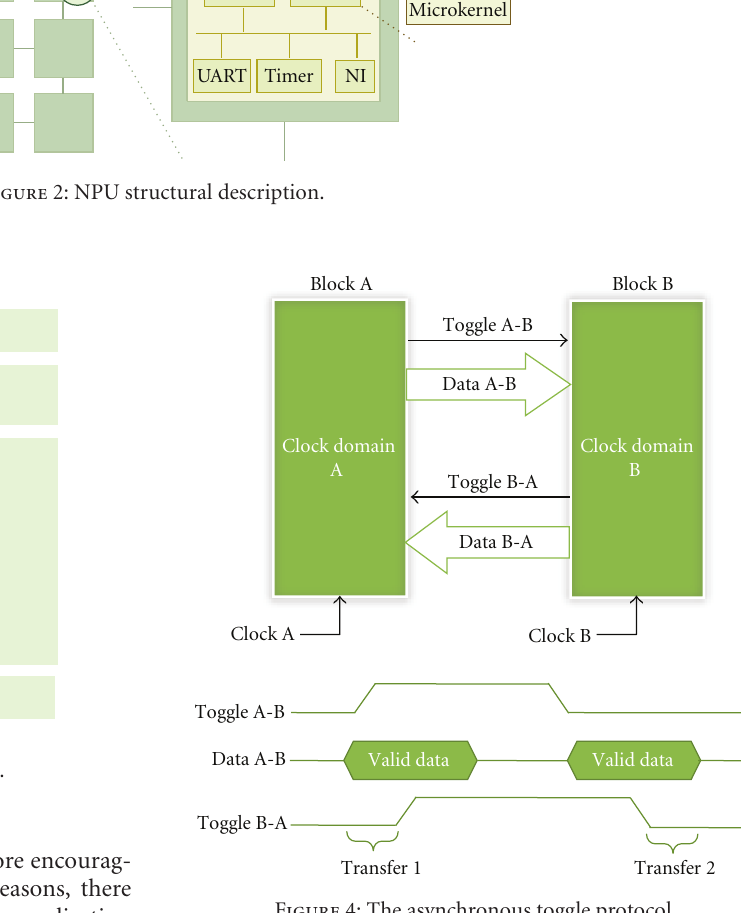
Figure 4: The asynchronous toggle